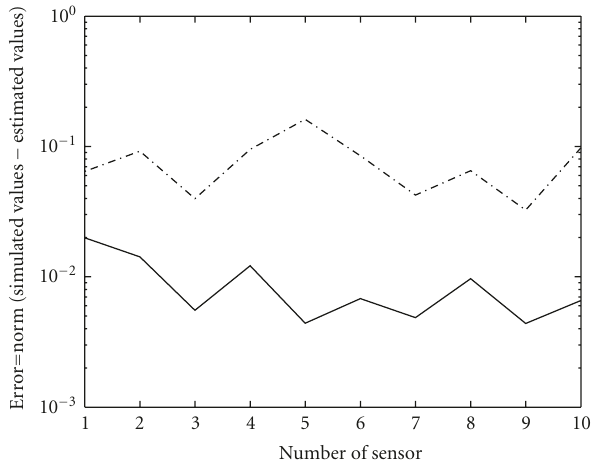
matrix and those of the estimated matrix for K = 3 and K = 5.